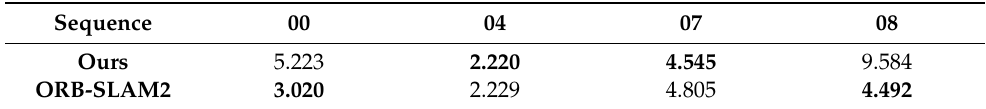
Table 3. Mean relative pose error (RPE) (cm) on the KITTI dataset. Bold numbers represent the best performances.